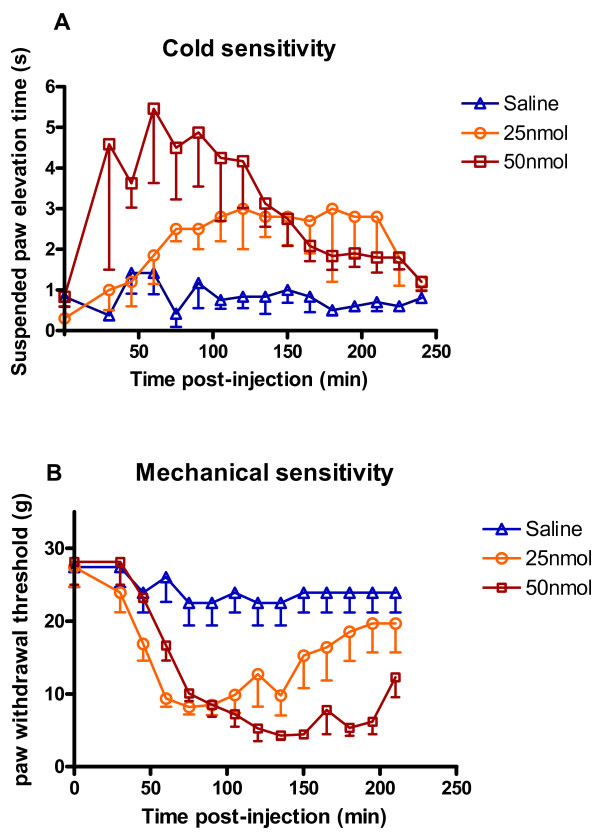
The effects of intrathecal TLQP-62 and saline vehicle on reflex withdrawal responses to innocuous cold and mechanical stimuli in naive rats. A. Mean suspended paw elevation time in seconds to acetone applied to the hind paw B. Mean paw withdrawal threshold (g) to mechanical von Frey hair stimulation after intrathecal administration of TLQP-62. Each point is the mean of 8 rats.